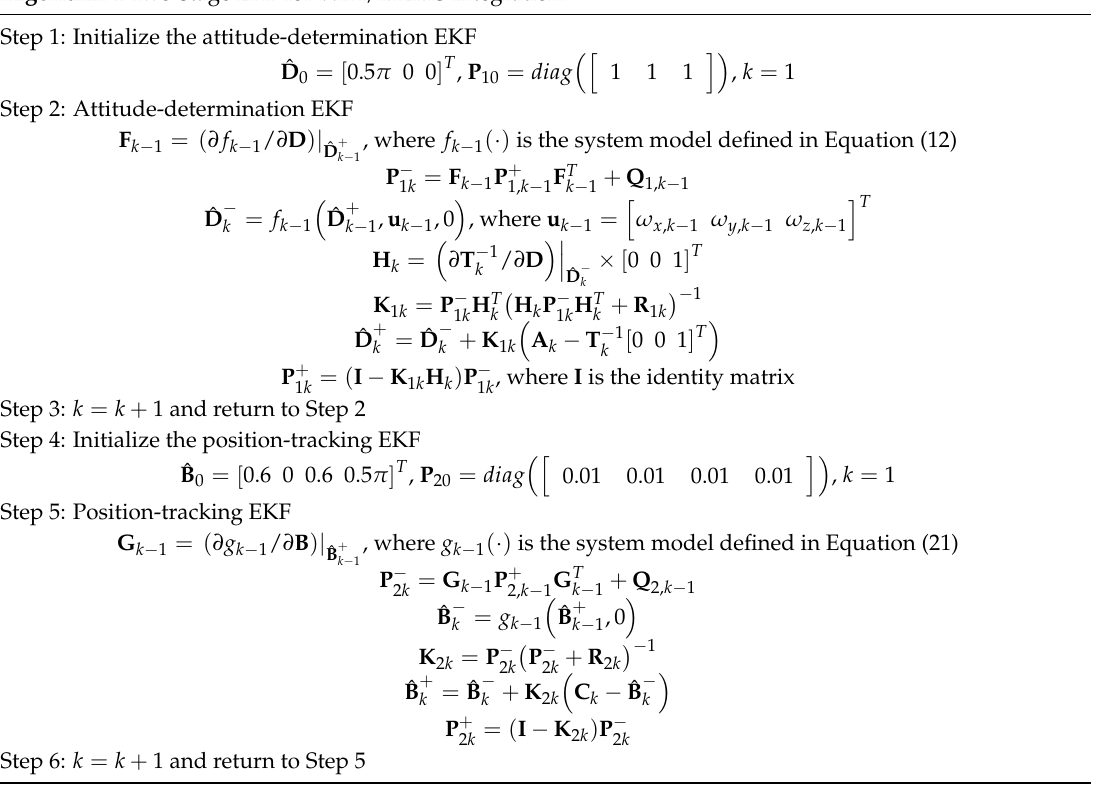
Algorithm 1 Two-stage EKF for WiFi/MEMS